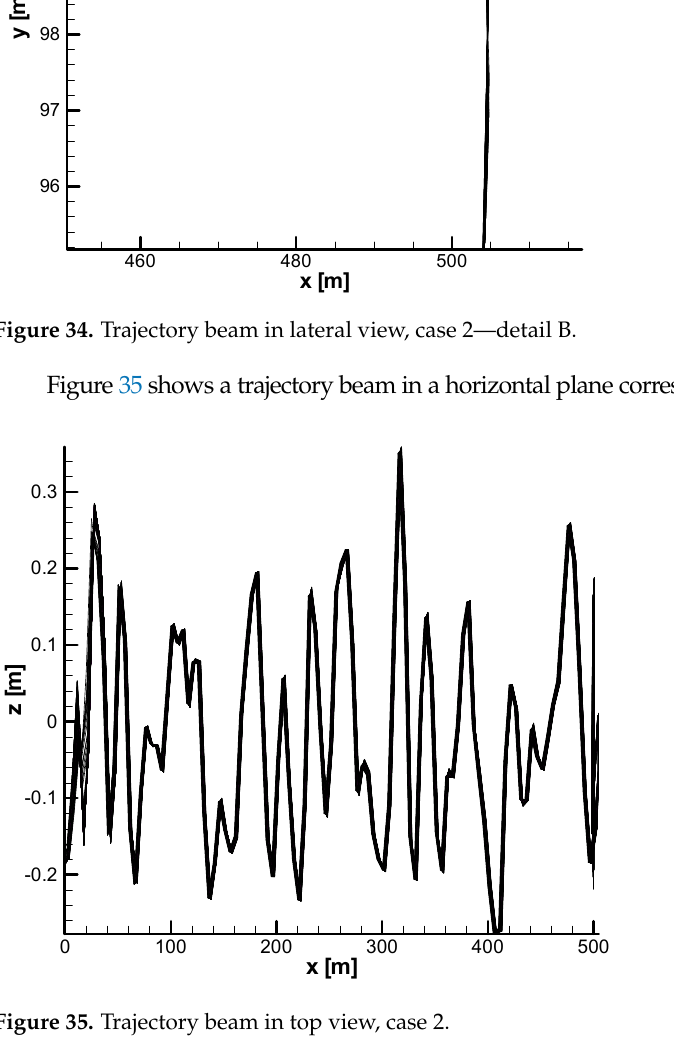
Figure 35. Trajectory beam in top view, case 2.